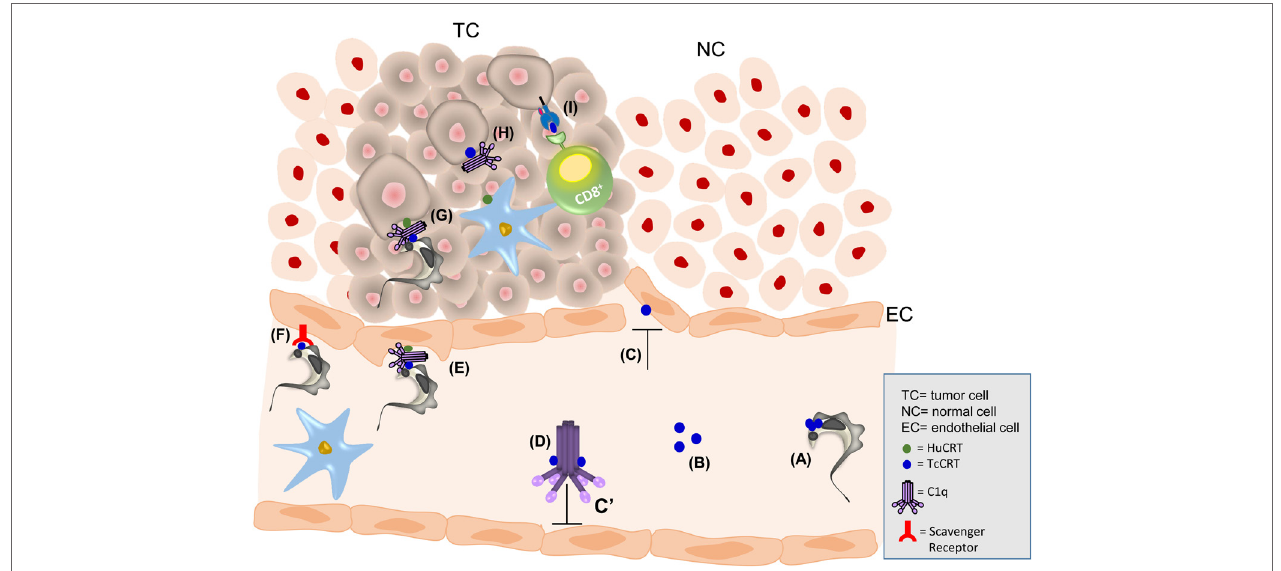
FiGURe 1 | The antitumor effect of T. cruzi infection may be explained by TcCRT . TcCRT is exposed on the parasite surface (A) and secreted (B) . TcCRT inhibits angiogenesis (C) and the activation of the classical pathway of the complement system through C1 inactivation (D) . TcCRT, present on the parasite surface, recruits C1. On the EC membrane, a trimolecular synapse is formed by HuCRT/C1q/TcCRT. This interaction increases the infectivity process (e) . TcCRT is also recognized by SRs on ECs, promoting infectivity (F) . The HuCRT/C1q/TcCRT interaction can also promote T. cruzi infectivity in TCs (G) . Moreover, TcCRT could mediate induction of an anamnestic antitumor immune response. Parasite could translocate TcCRT bound to the tumor cell with subsequent capture of host C1 (H) . This C1 will be recognized by HuCRT present on an antigen-presenting cell (APC), followed by internalization of this complex. Among many other possibilities, APCs will cross-process TcCRT, and specific peptides from this parasite protein will be loaded onto MHC I molecules. APCs will enter the regional lymph node and present these nTcCRT-specific peptides to cytotoxic T lymphocytes, thus leading to their activation. These CD8 + cytotoxic T lymphocytes will leave the lymph node and kill tumor cells that also present TcCRT-derived peptides (i)